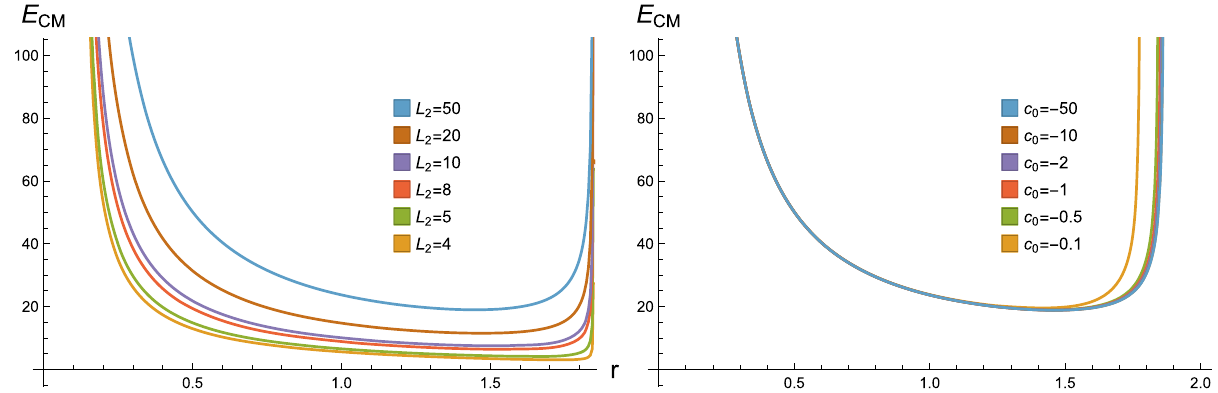
Fig. 9 Dependence of the CM energy E CM on the radial distance r for different values of the spin and symmergent parameters. We consider two parameter sets m = M = 1, L 1 = − 4, c 0 = − 0 . 5, ˆ α = 0 . 9 and